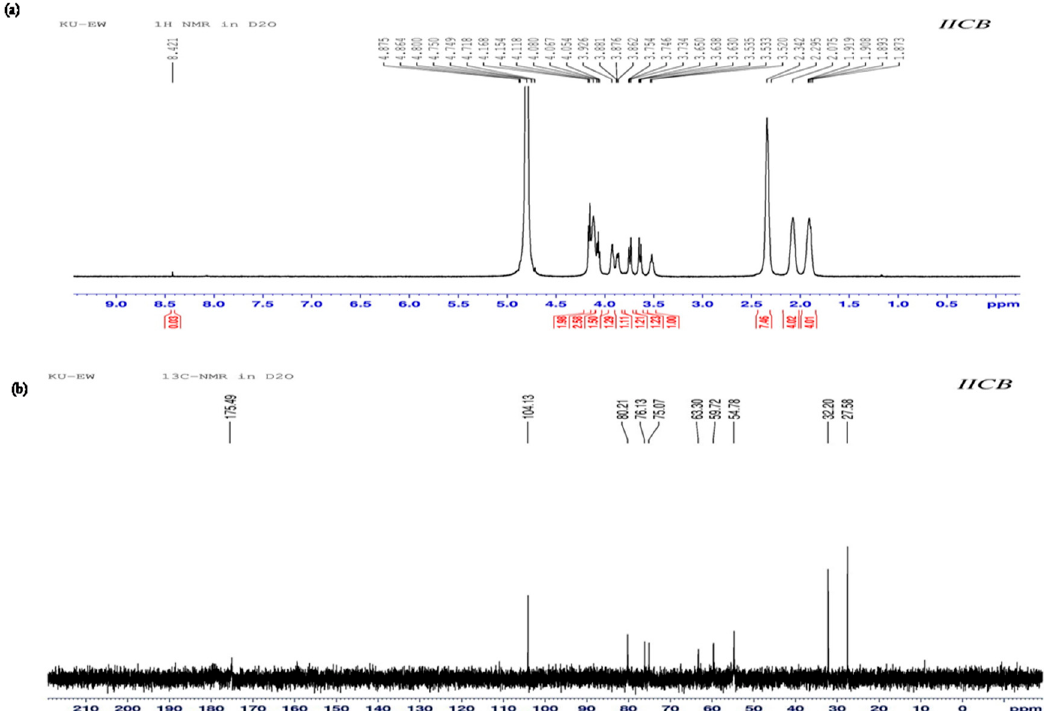
Figure 1. ( a ) 1 H Nuclear Magnetic Resonance (NMR) and ( b ) 13 C NMR signal positions of extracellular polymeric substance (EPS).